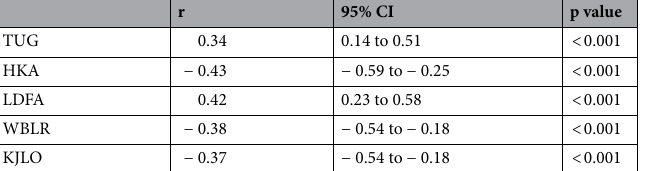
Table 4. Correlation between HAA and Clinical and functional scores and radiological parameters. HAA hip abduction angle, HKA hip-knee-ankle, FTA femoro-tibial angle WBLR weight-bearing line ratio, LDFA lateral distal femoral angle, KJLO knee joint line